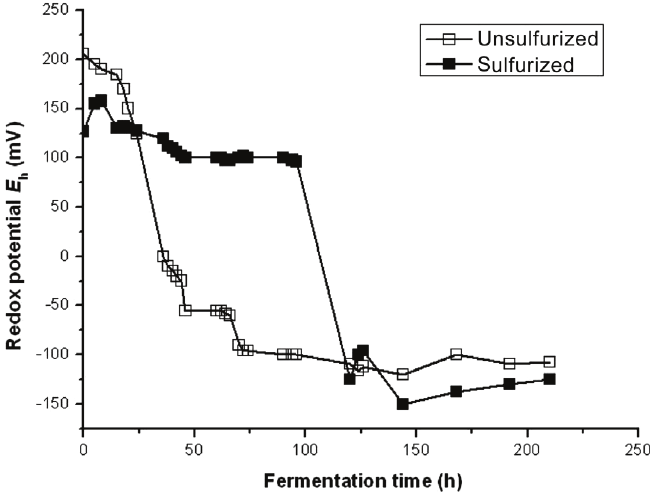
Fig. 2 – On-line redox potential measurements of unsul- furized and sulfurized fermentation